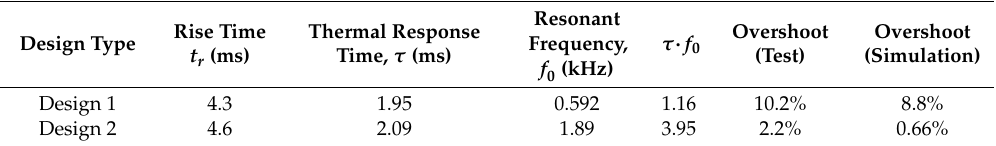
Table 2. τ · f 0 of the two different MEMS mirror Table 2. (cid:2028) ∙ (cid:1858) (cid:2868) of the two different MEMS mirror designs.